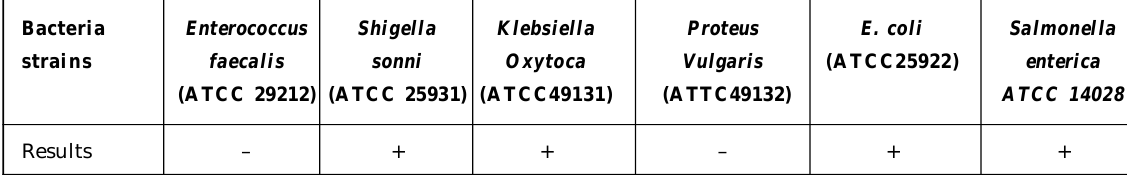
Table 4: Phage host range against six bacterial isolates (Source of isolates: (ATCC) using spot assay technique